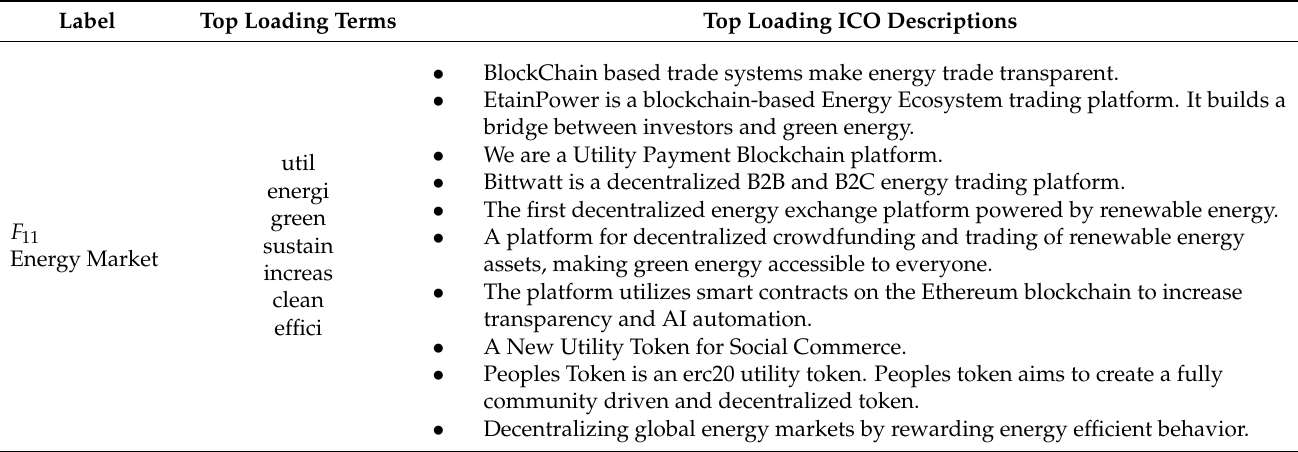
Table A11. Energy